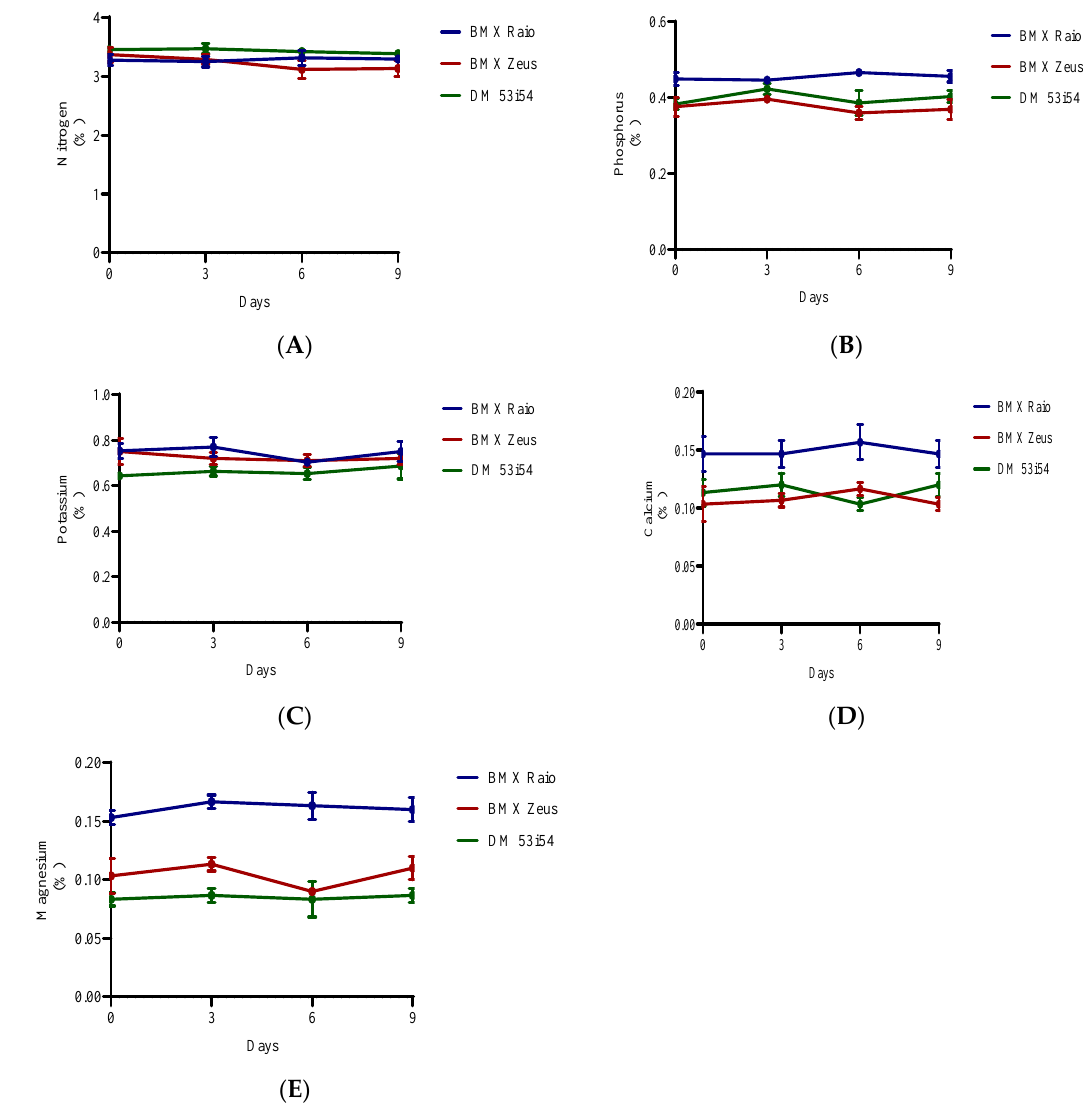
Figure 5. Macronutrients (nitrogen ( A ), phosphorus ( B ), potassium ( C ), calcium ( D ), and magnesium ( E )) of soybean seed embryonic axis of three cultivars (BMX Raio, BMX Zeus, and DM 53i54) exposed (0, 3, 6 and 9 days).